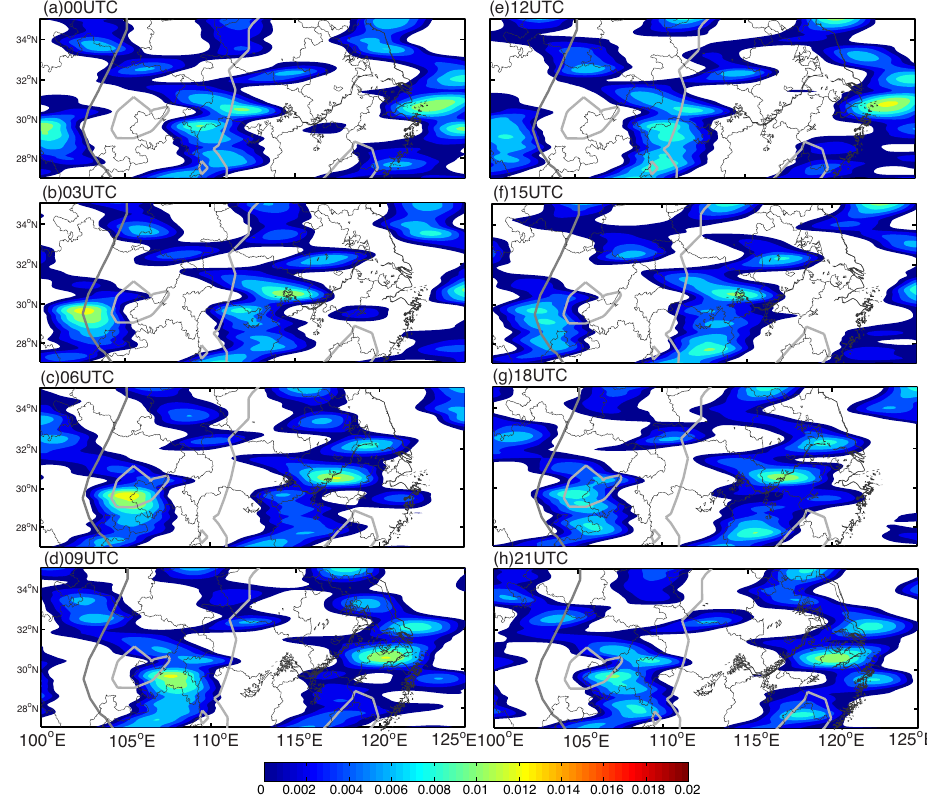
Figure 16. Similar to Fig. 11 but for SR2-filtered perturbations (units: mmh − 1 ) over East Asia for periods between 8–24h and zonal wavelengths between 800–1400 km. 3